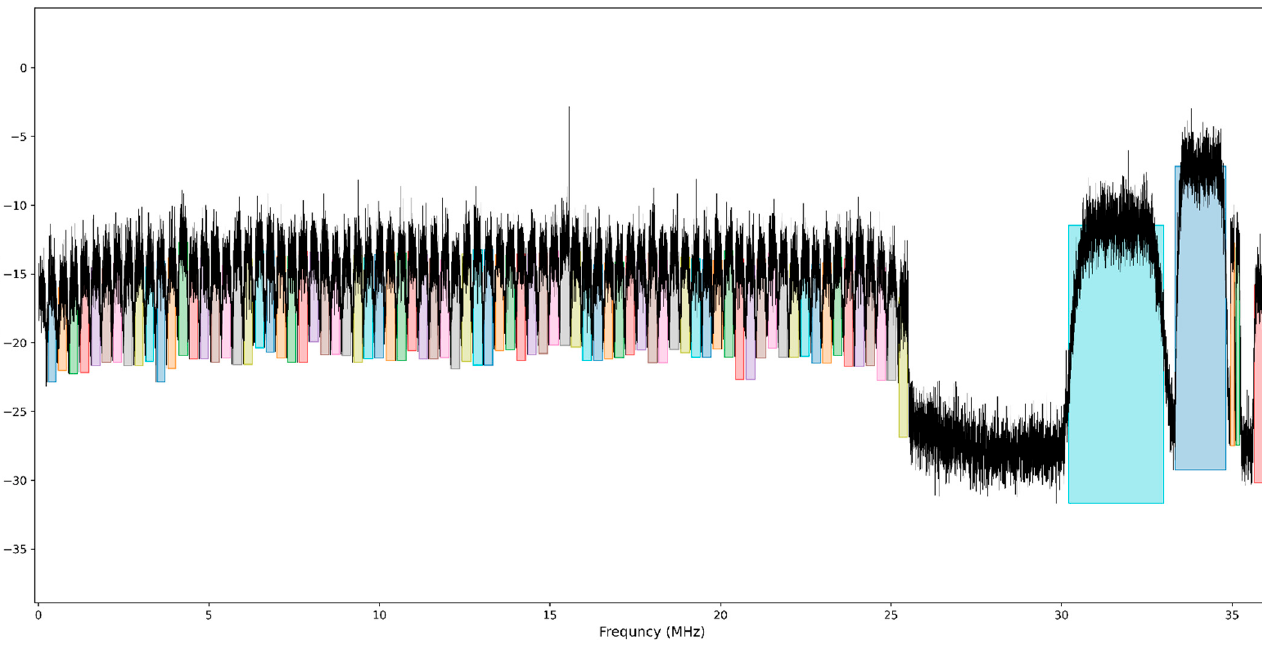
Figure A1. Example1 of the actual satellite broadband power spectrum set.